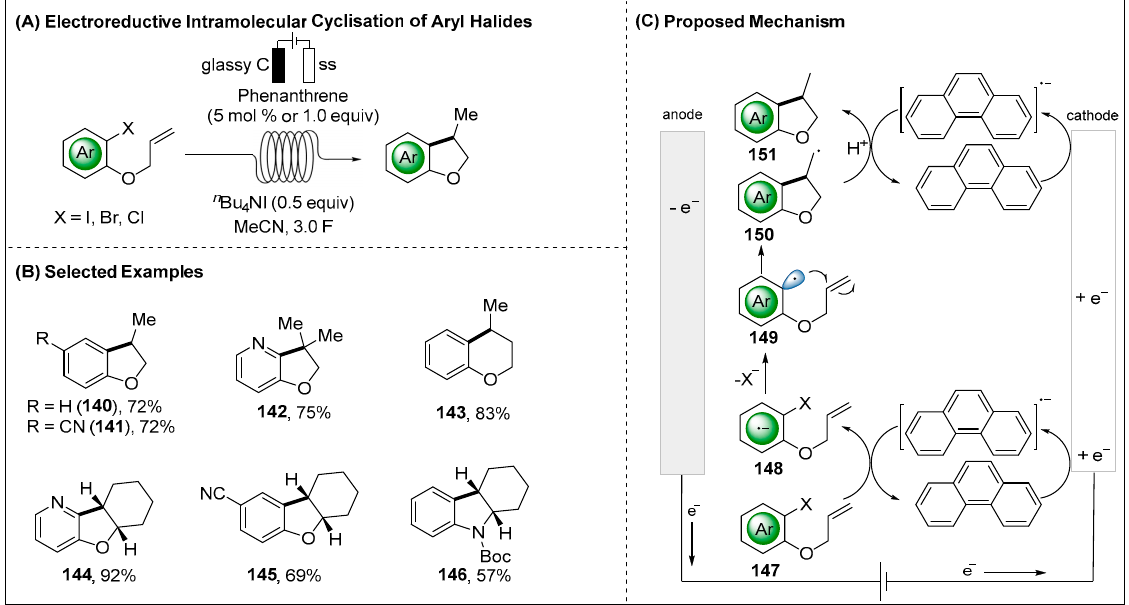
Figure 17. Electrophotochemical reductive transformation of aryl halides, DCA = dicyanoanthracene.